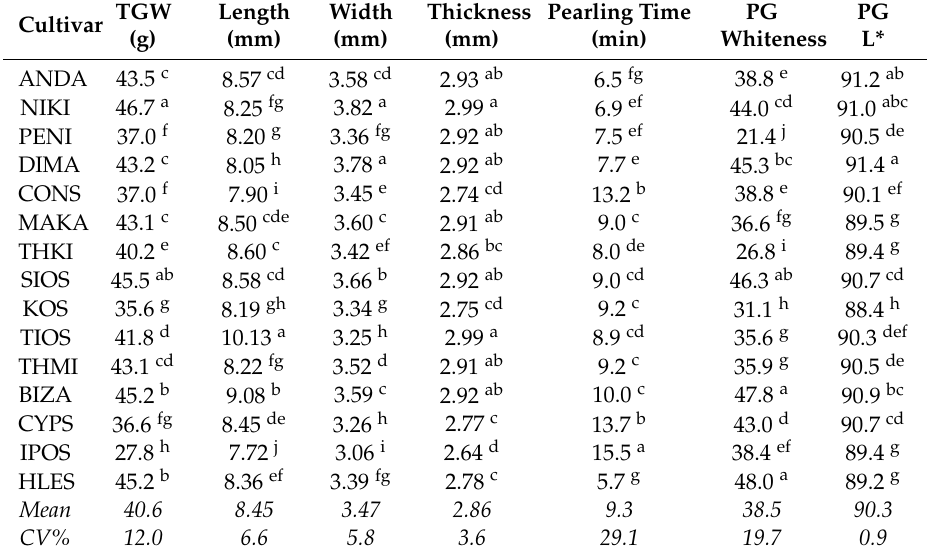
Table 1. Mean physical characteristics of the commercial barley cultivars used in the present study. TGW Length Width Cultivar (g) (mm)